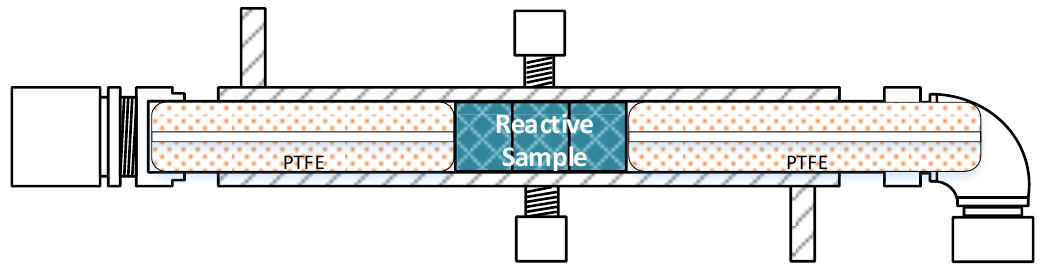
Figure 1. Large Temperature Jump (LTJ) reactor design; cross hatched area represents reactor heating oil jacket.